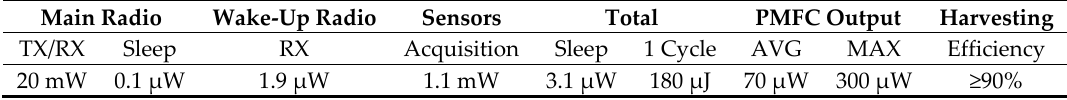
Table 1. Power consumption and generation